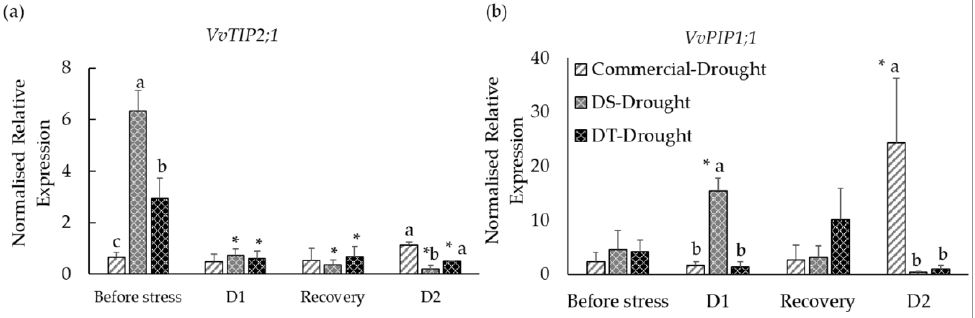
Figure 5. Relative gene expression (fold changes) of two aquaporin genes, ( a ) VvTIP2;1 and ( b ) VvPIP1;1 in Cabernet clones in response to dehydration and rehydration during two drought cycles. Values are means ± SEM of four biological replicates. Statistical analysis was conducted using two- way ANOVA. Asterisks indicate statistically significant differences ( p < 0.05) of drought treated clones relative to before imposing the drought stress. Lowercase letters indicate statistically signifi- cant differences ( p < 0.05) between drought treated clones within each treatment.